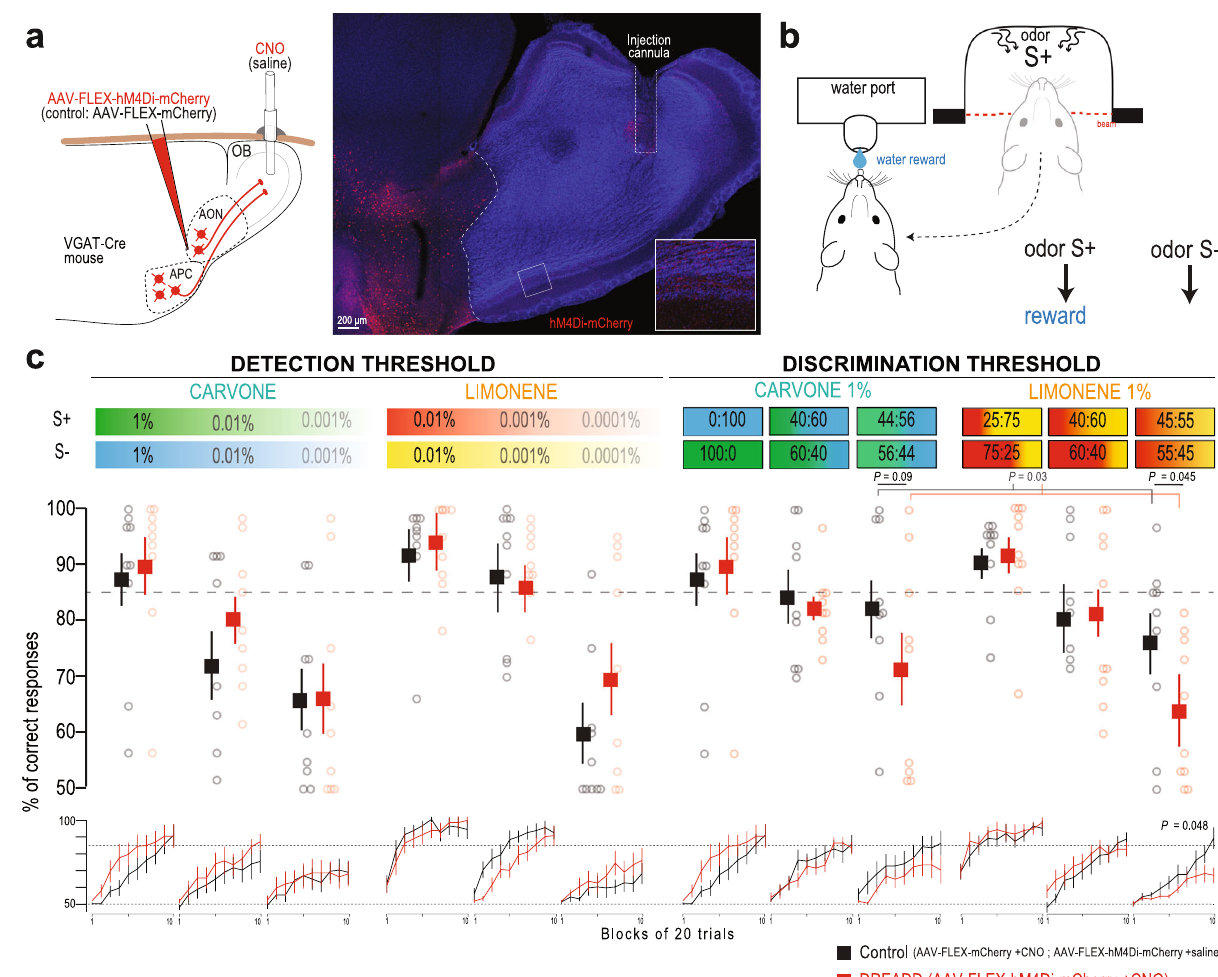
Fig. 7 | Targeted pharmacogenetic inhibition of cortico-bulbar GABAergic axons impairs fi ne odor discrimination. a Speci fi c silencing of axonal outputs of AOCGABAergicneuronexpressinghM4Di-mCherrybylocallyinjectingCNOinthe OB (0.1mg/mL, 1 µ L per hemisphere). Control animal expressed the protein mCherry and received bilateral CNO injection. Right, Coronal section showing hM4Di-mCherry + GABAergiccellsintheAONandtheiraxonalprojectionsintheOB, togetherwiththetrackoftheinjectioncannulatargetedtothecoreoftheOB.Inset: high magni fi cation of the boxed region with increased red fl uorescence gain. b Odor-reward association task. After a nose poke into the odor port, mice had to lickontherewardedodor(S + )toobtainawaterrewardandrefrainedlickingonthe non-rewarded odor (S − ). c Performance (percentage of correct responses) for the discriminationofthecarvone(green/blue)andlimonene(red/yellow)enantiomers.